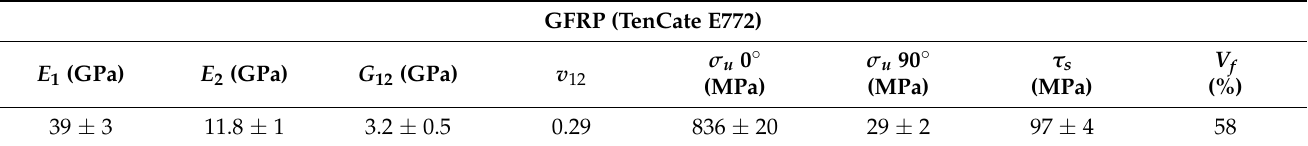
Table 2. Material properties of GFRP (TenCate E772)